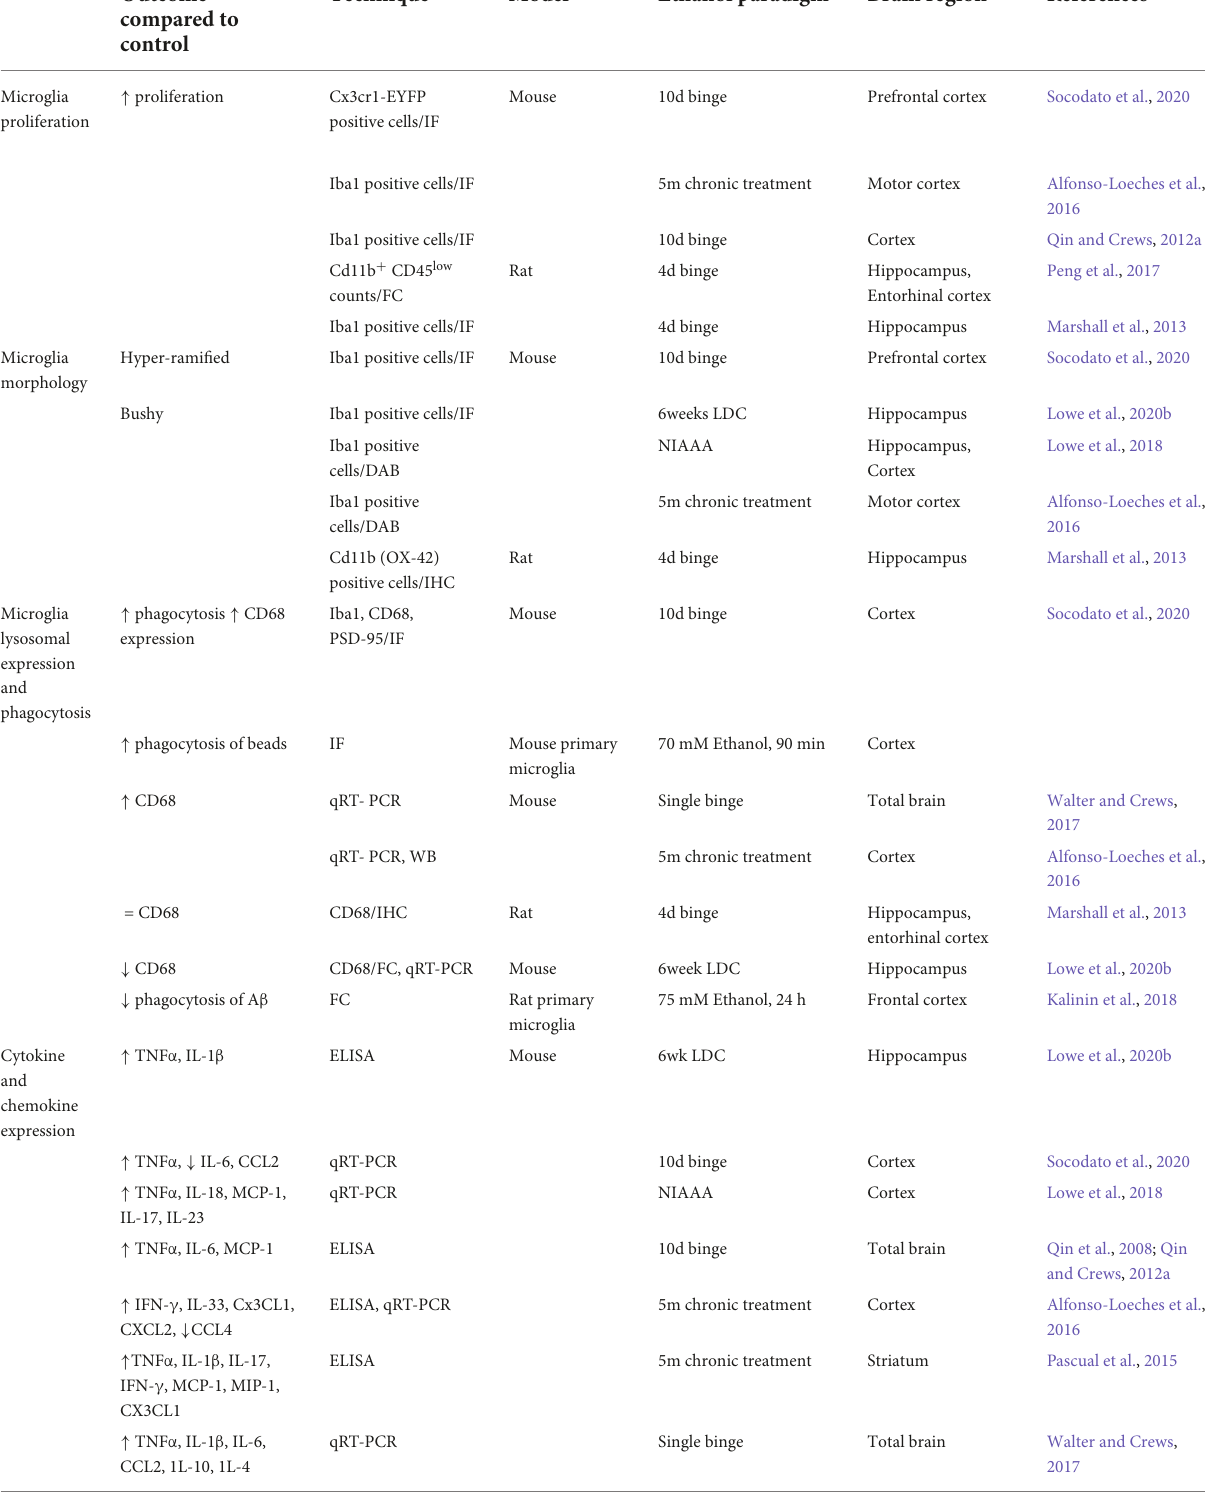
TABLE 1 Features of innate immune activation in rodent models of alcohol use disorder. Outcome compared to control